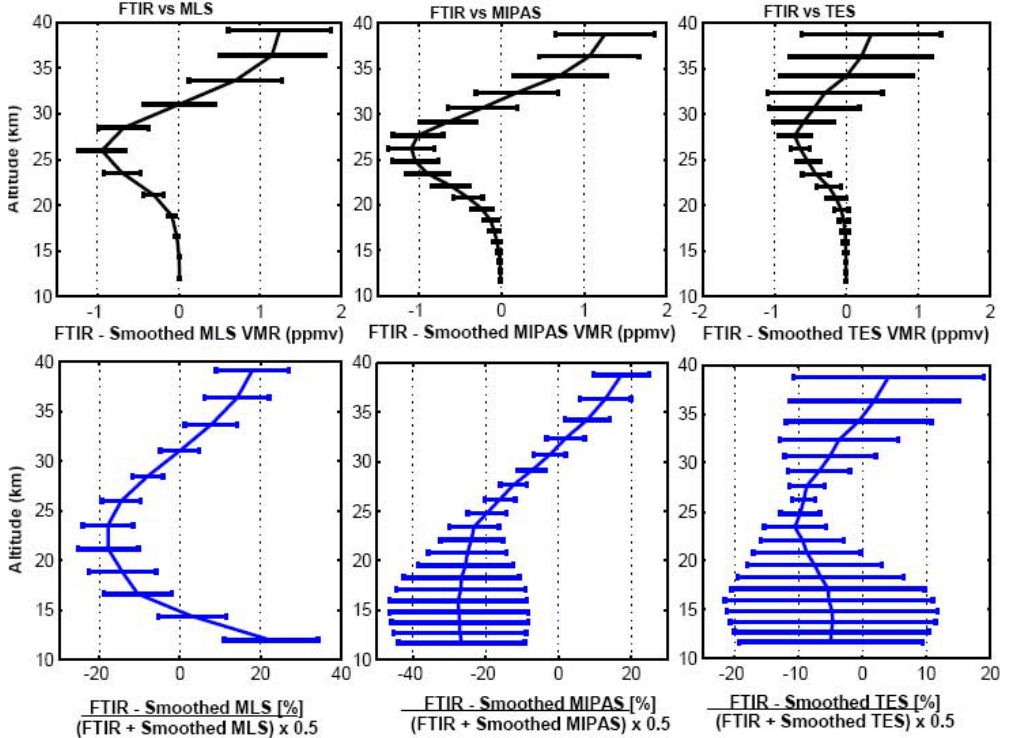
Fig. 6. Statistics for intercomparison of O 3 VMR profiles between FTIR and satellites instruments (MLS, MIPAS and TES). Top: mean of the differences and its standard deviation (shown as error bar) for FTIR-MLS (left), FTIR-MIPAS (middle) and FTIR-TES (right). Bottom: the same as top panels but for relative